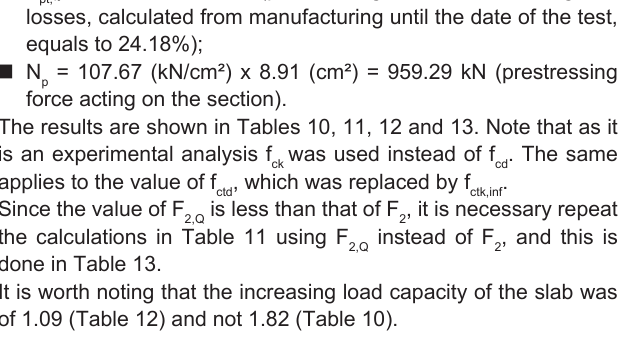
Figure 15 – Test with continuity and concentrated load at 2.10